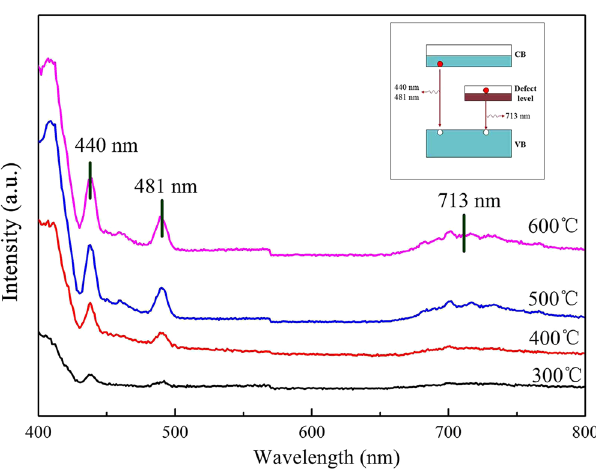
Figure 9. Photoluminescence spectra of MoO 3 synthesized at different